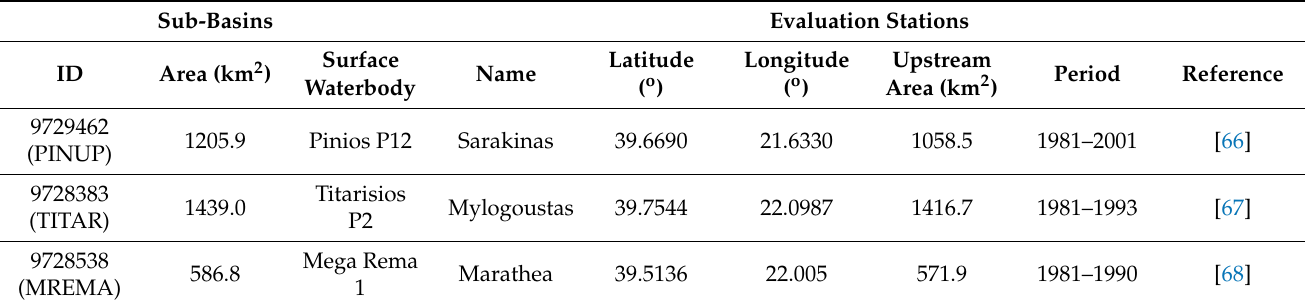
Table 2. The main characteristics of the monitoring stations of the Ministry of Environment and Energy of Greece used for the